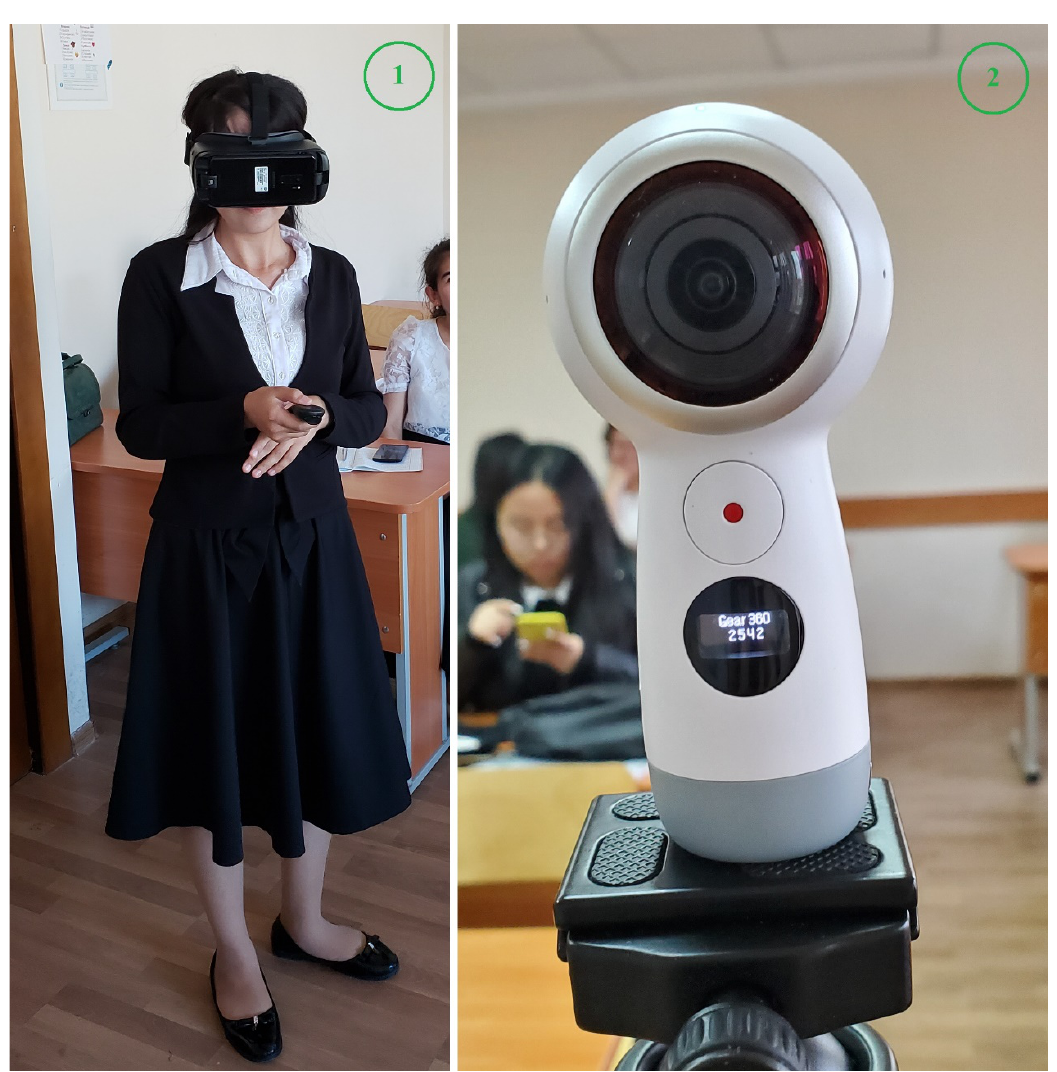
Figure 2 . VR technology: (1) Samsung Gear VR, and (2) Samsung Gear